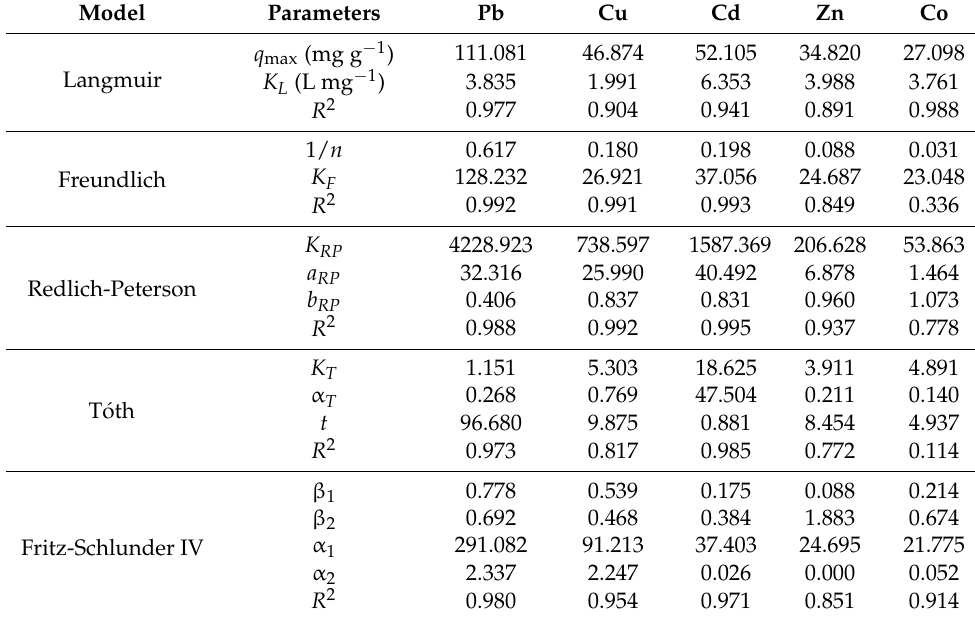
Table 5. ZRef-FAU nonlinear adsorption isotherms ( C 0 = 100 to 500 mg L − 1 at 90 min and 5 g L − 1 adsorbent